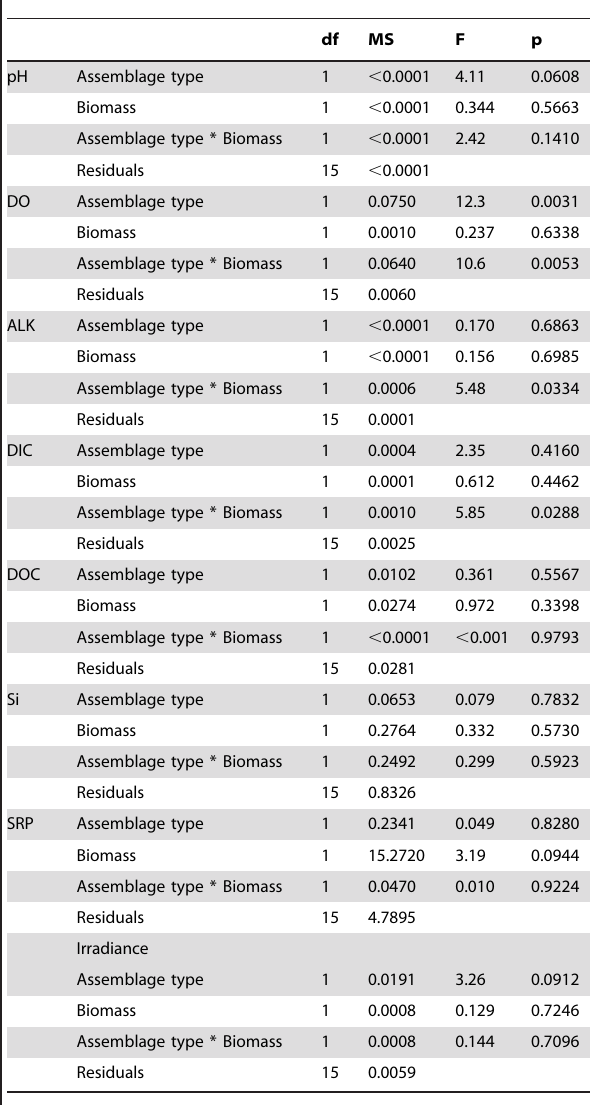
Results of two way ANOVA comparing the effects of macroalgal assemblage type (mat- or canopy forming) and macroalgal biomass on the ratios (underneath vs above) of pH, dissolved oxygen (DO, %) alkalinity (ALK, m Eq/kg), dissolved inorganic carbon (DIC, m M), dissolved organic carbon (DOC, mg L 2 1 ), silicic acid (Si, m M), soluble reactive phosphorus (SRP, m M) and irradiance ( m mol photons m 2 2 s 2 1 ) (see also Fig.